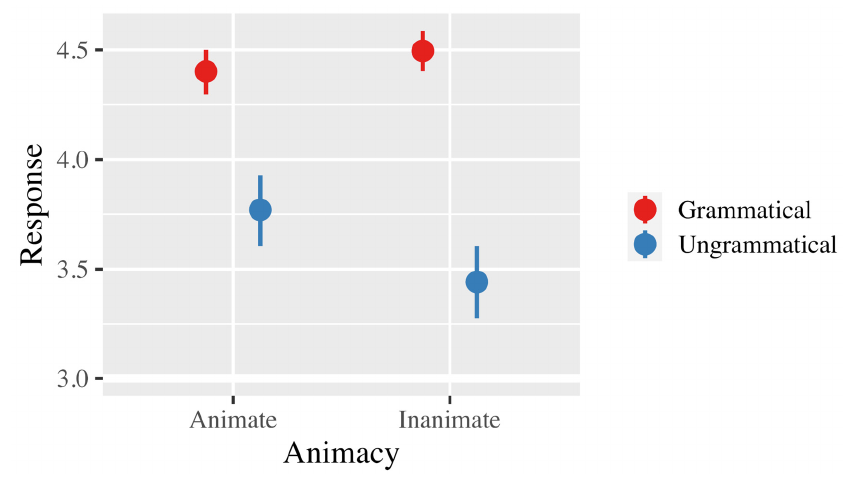
Figure 4. Distribution of acceptance (i.e., response) based on animacy and grammaticality in the BP AJT. Table 10. Distribution of acceptance with mean and standard deviation based on animacy and grammaticality in the BP AJT.